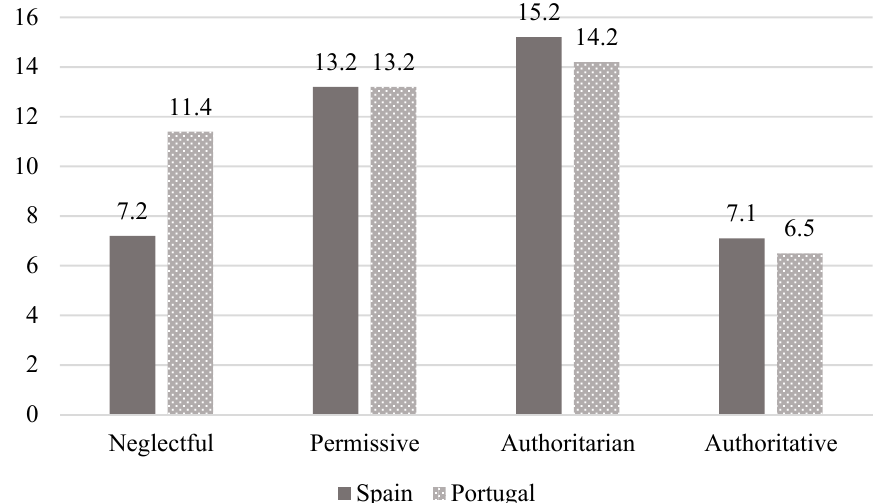
Figure 1. Parenting style distribution by country.